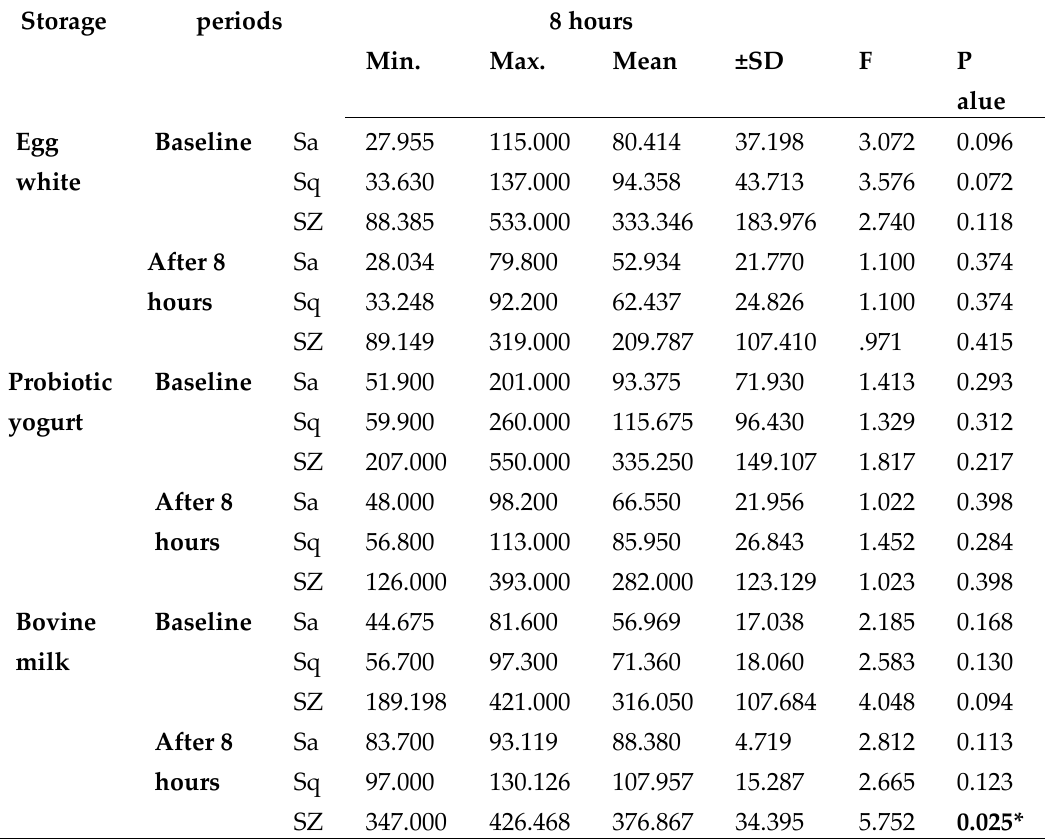
Table 4 : Descriptive and statistical test of roughness among periods by storage media